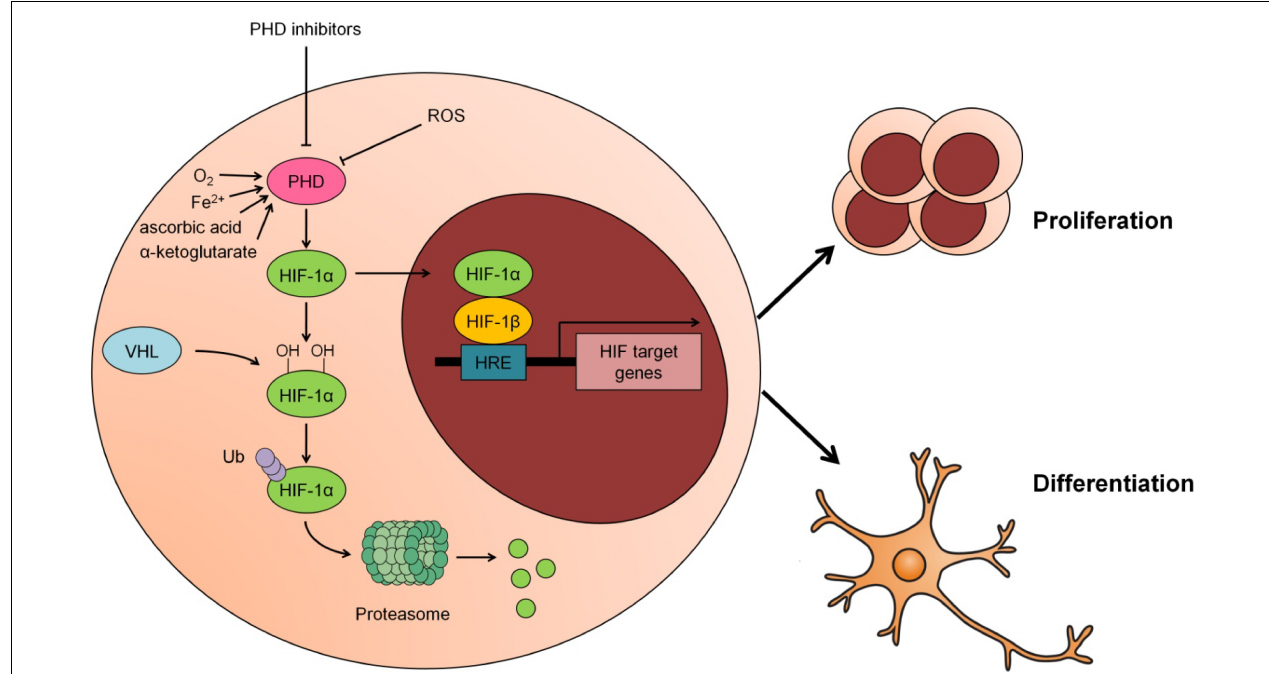
FIGURE 1 | Modulation of PHD-HIF1 signaling on neural stem cells (NSCs). Under normoxia, HIF-1 α is hydroxylated by PHD at 402 and 564 residues and subsequently recognized and ubiquitinated by the E3 ligase VHL, hereafter, degraded in the proteasome. In response to hypoxia, ROS or PHD inhibitors, the activity of PHD is suppressed and the hydroxylation of HIF-1 α by PHD is inhibited. As a result, the stabilized HIF-1 α translocates to the nucleus and partners with HIF-1 β to form a heterodimer that transcriptionally activates its downstream target genes to promote proliferation or differentiation of NSCs.